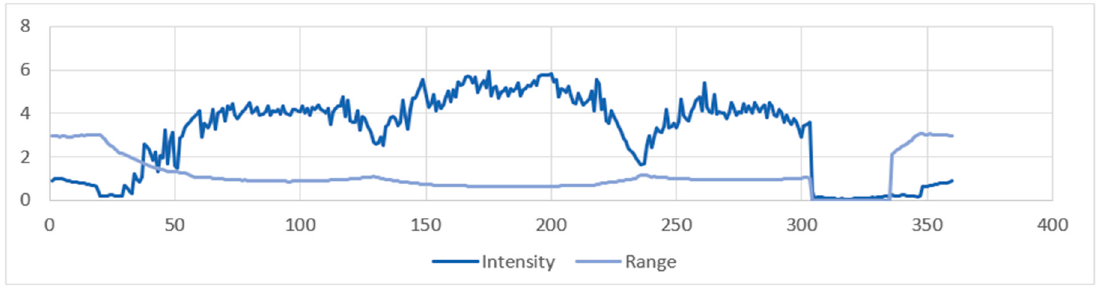
Figure 17. The 360 received intensity laser scan points mapped linearly for the Figure 16.